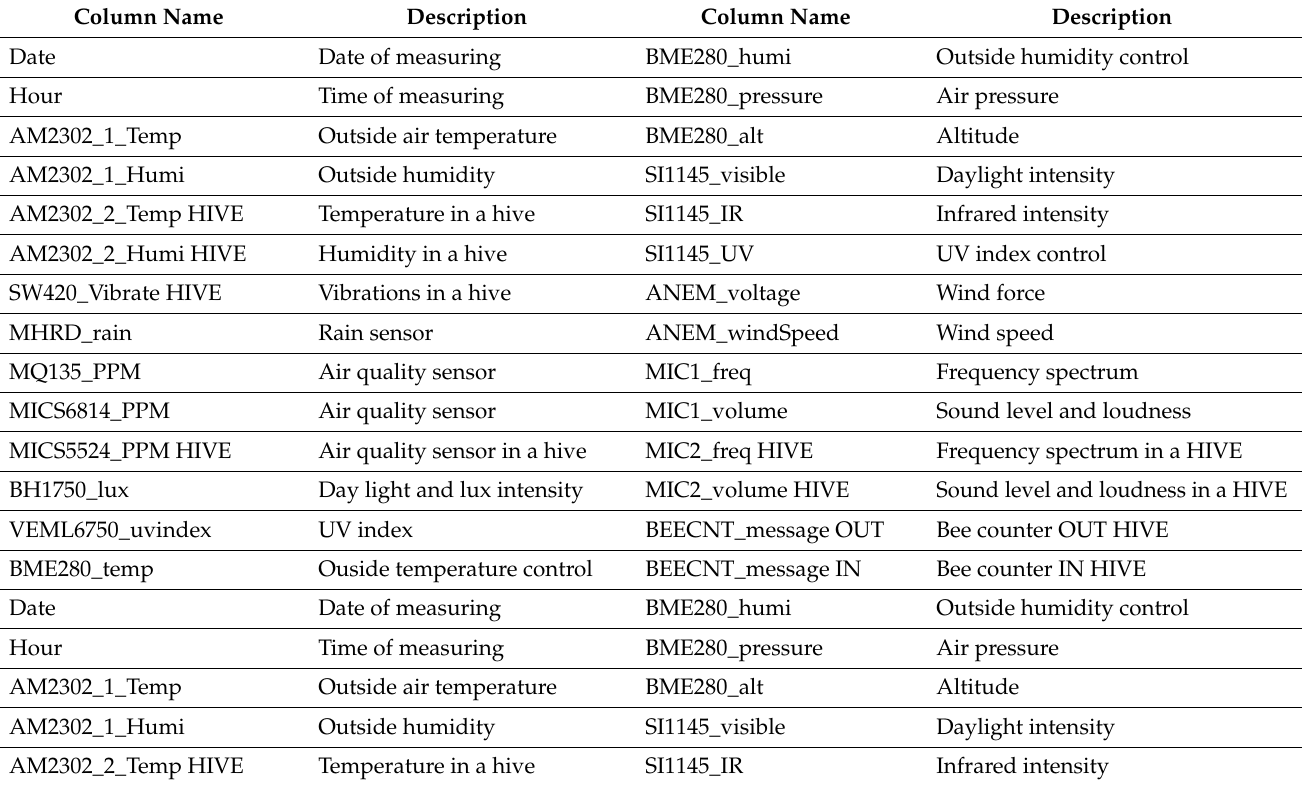
Table 1. Sensors, control sensors, and description of